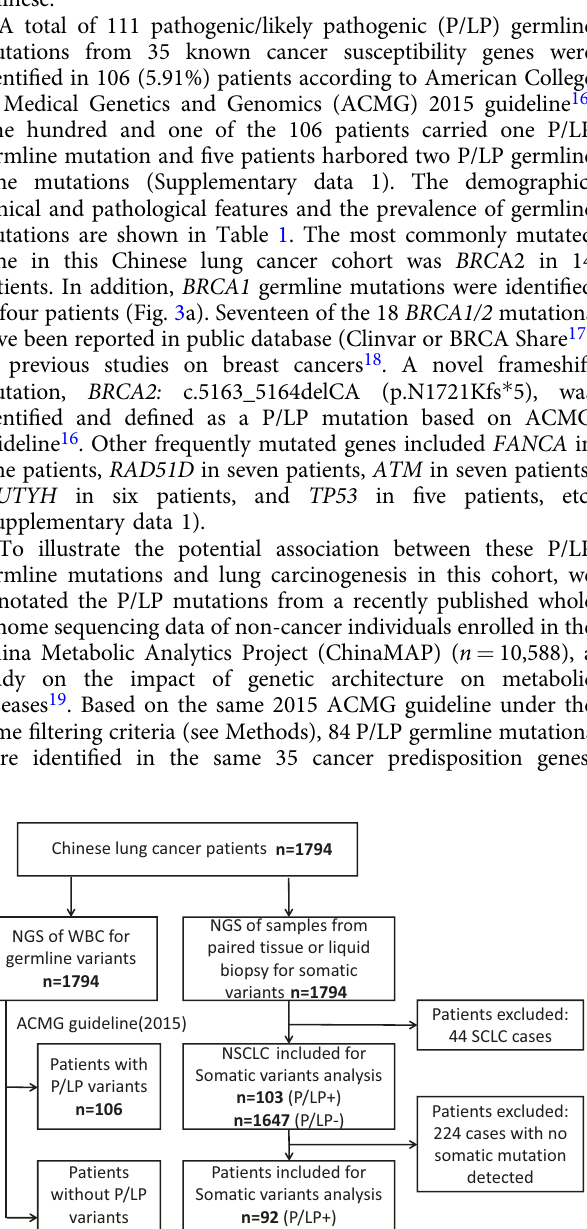
casesACMG guideline(2015)